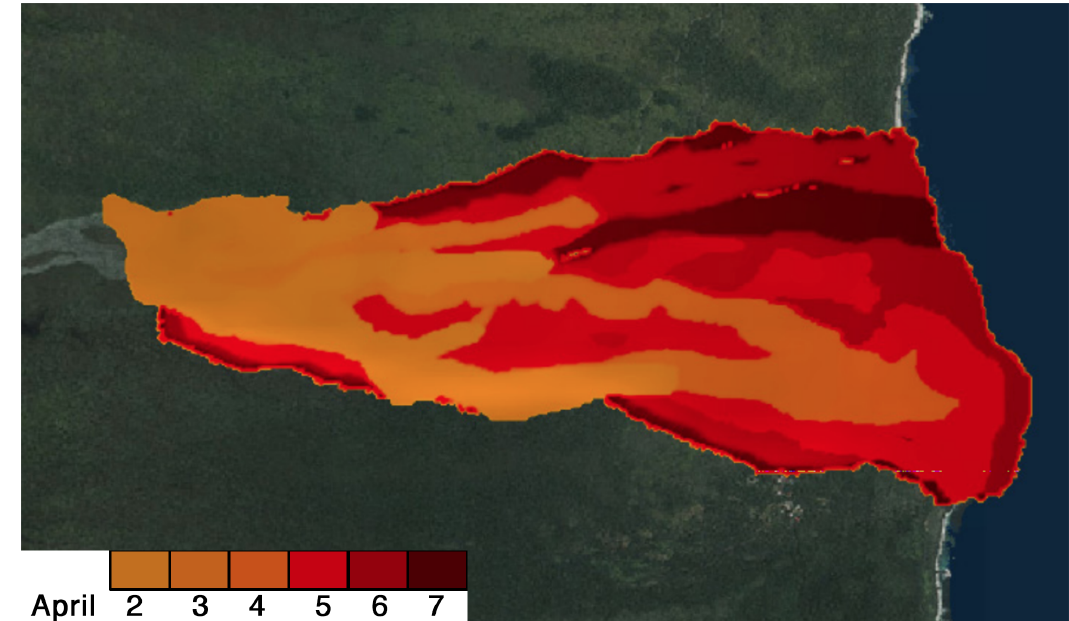
Figure 2. Arrival time matrix for lava flow. The lightest orange corresponds to the first lava flows of 2 April and the darkest red to the last flows of 7